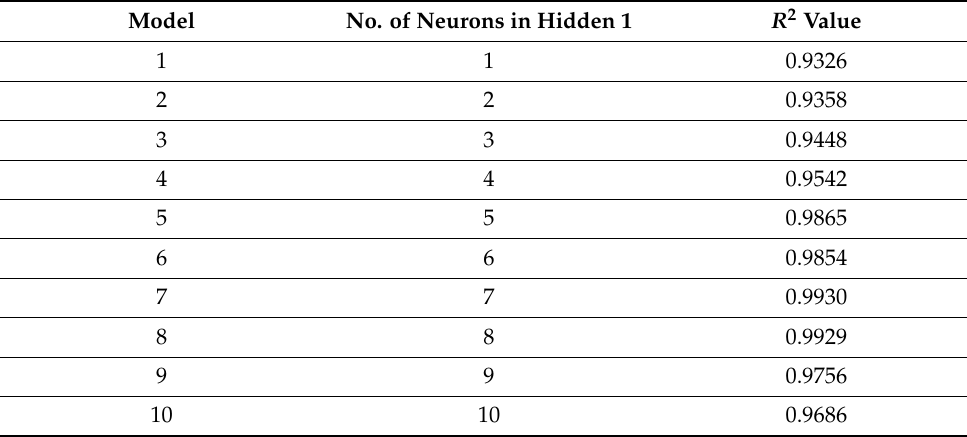
Table 8. Performances of the developed ANN models based on their R 2 value. Model